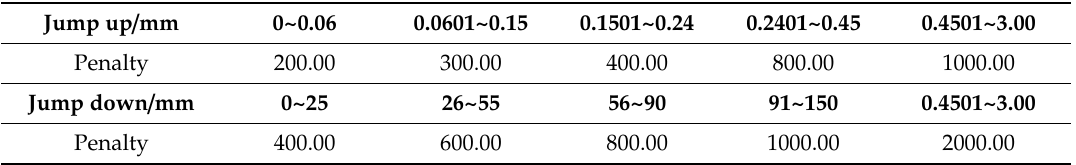
Table 3. Penalty of thickness jump.